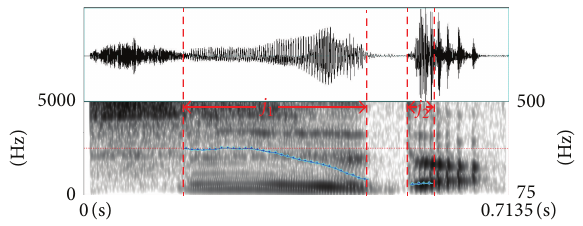
Figure 1: Example of segment boundaries estimation for the phrase “shide.”Theverticalbarsrepresentthesegmentboundariesfromthe critical points of pitch